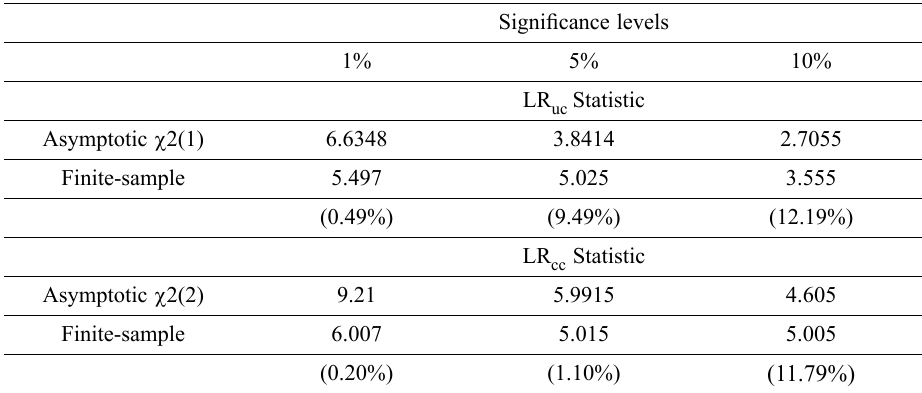
Table A1. Differences between the finite sample critical value and the